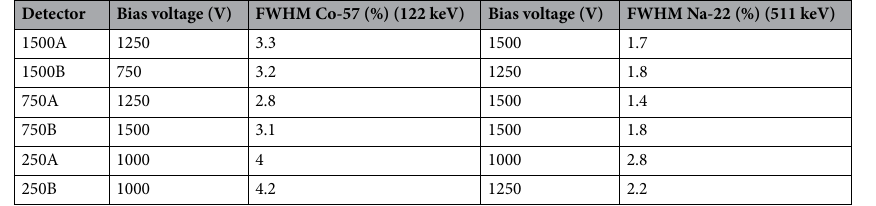
Table 2. Energy resolution obtained at 122 and 511 keV for the six detectors. The detector name refers to the anode diameter in µm. The bias voltage indicated is the one related to the best FWHM obtained. Measurements were carried out at 20 °C.